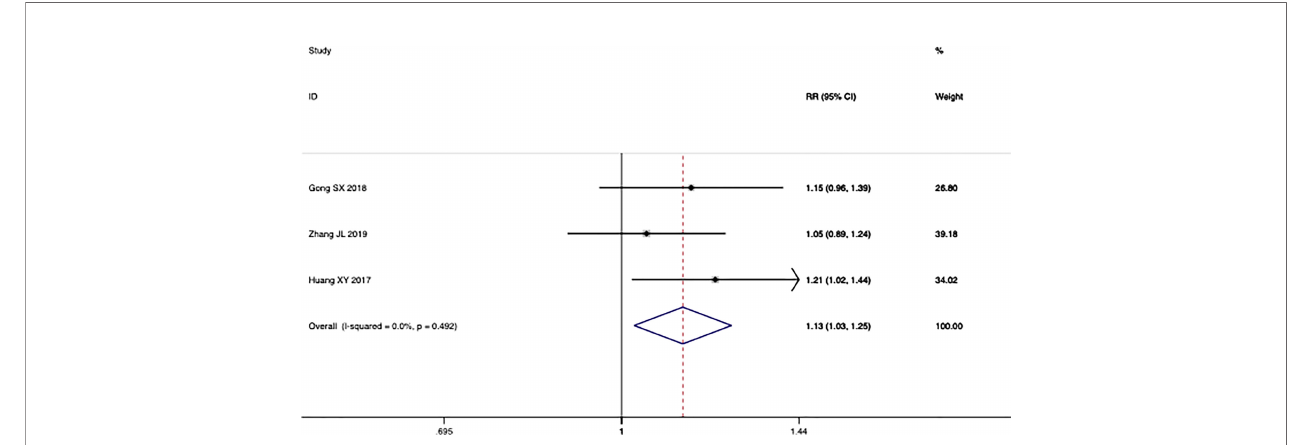
FIGURE 4 | Forest plot of the meta-analysis of the disease control rate (DCR) between the intervention group and the control group.